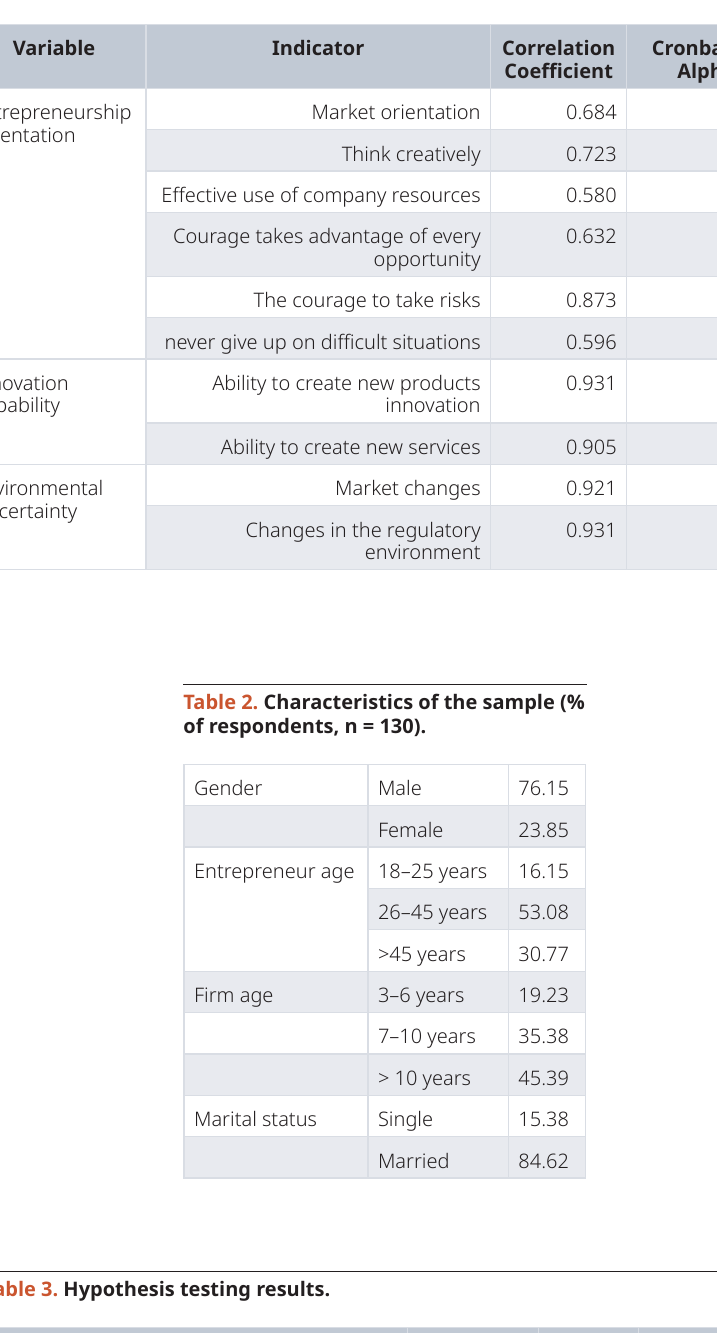
Table 1. Result of instrument validity test.